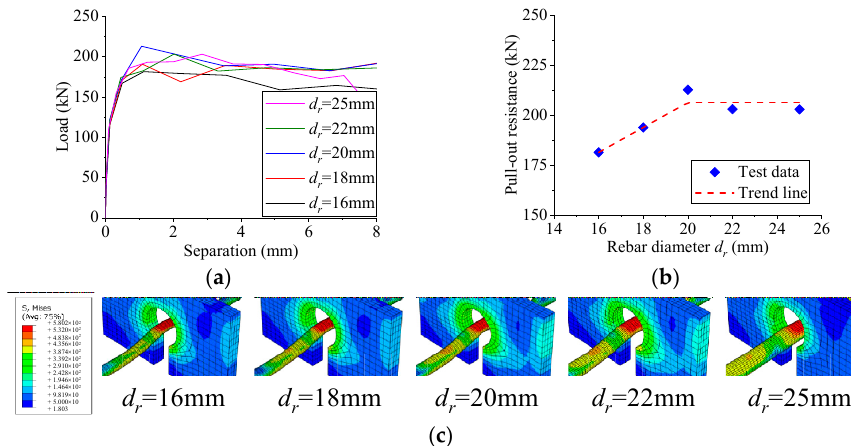
Figure 18. Influence of rebar diameter. ( a ) Load–separation curves; ( b ) influence analysis; ( c ) failure